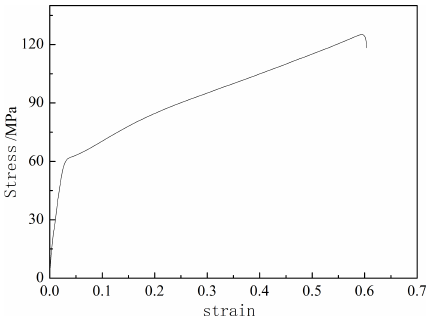
Figure 1: True stress-strain curve of